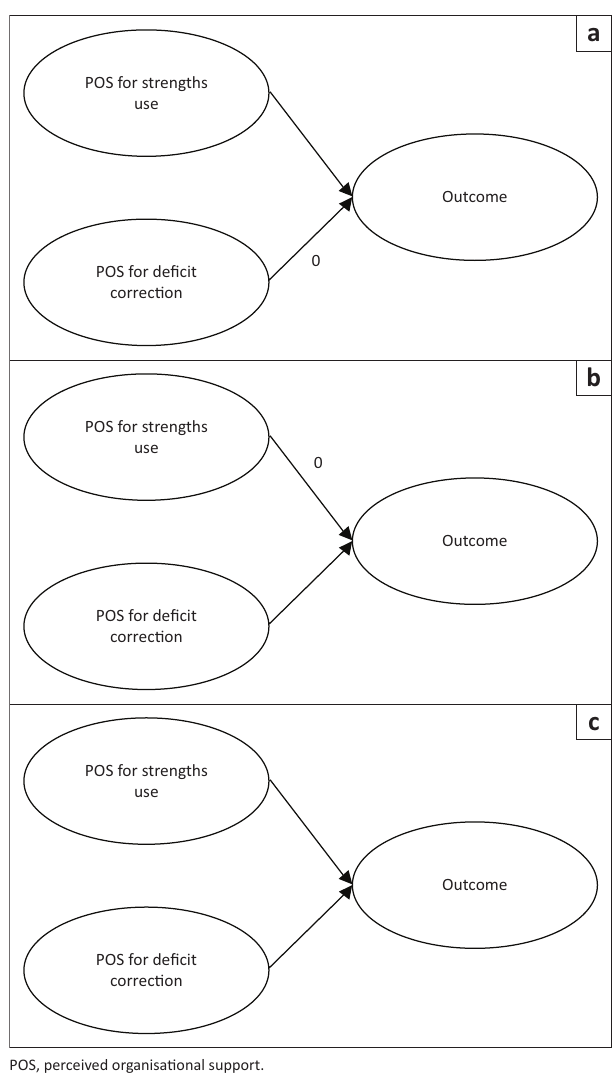
FIGURE 1: Conceptual models. (a) Model A, (b) Model B and (c) Model C.